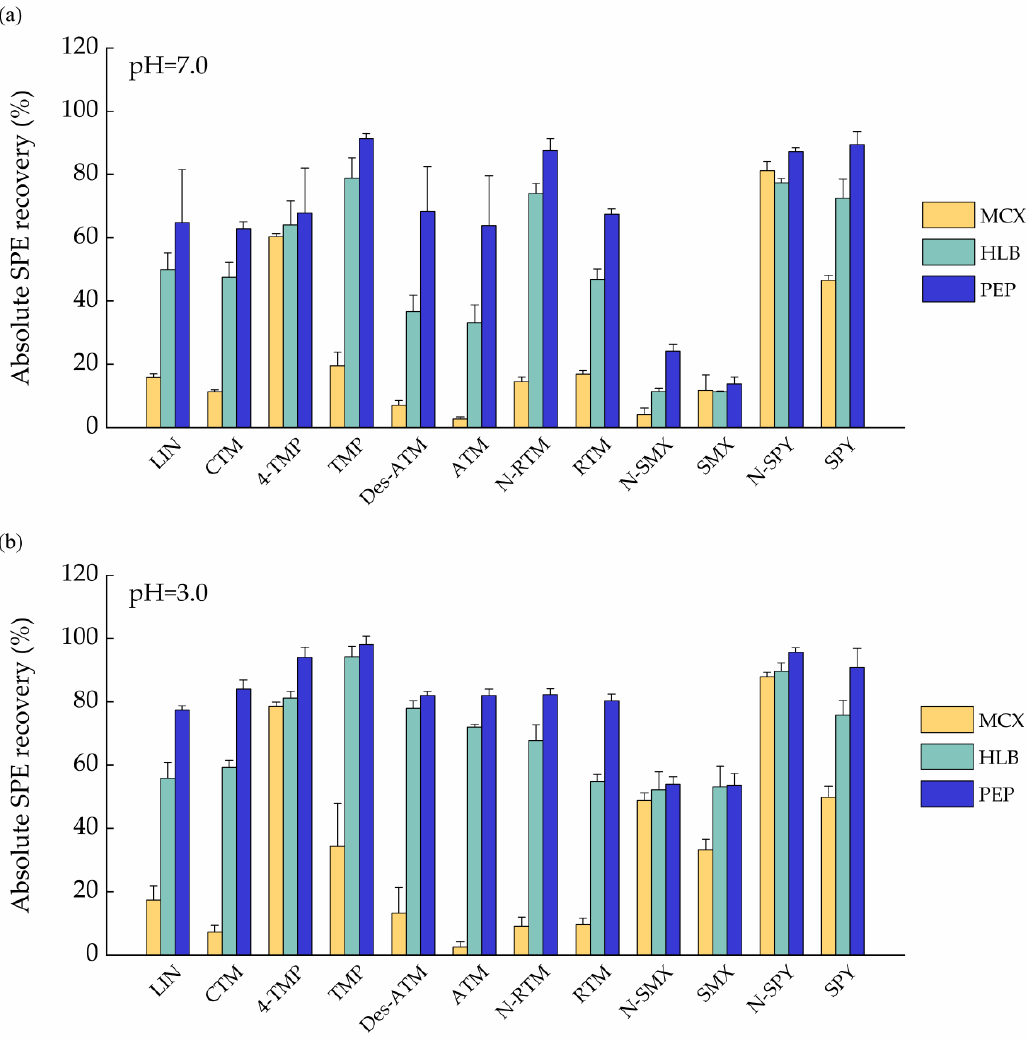
Figure 1. Absolute SPE recoveries of target analytes in ultrapure water samples enriched by various SPE cartridges (MXC, HLB, PEP) under different pH values. ( a ) pH = 7.0; ( b ) pH = 3.0.